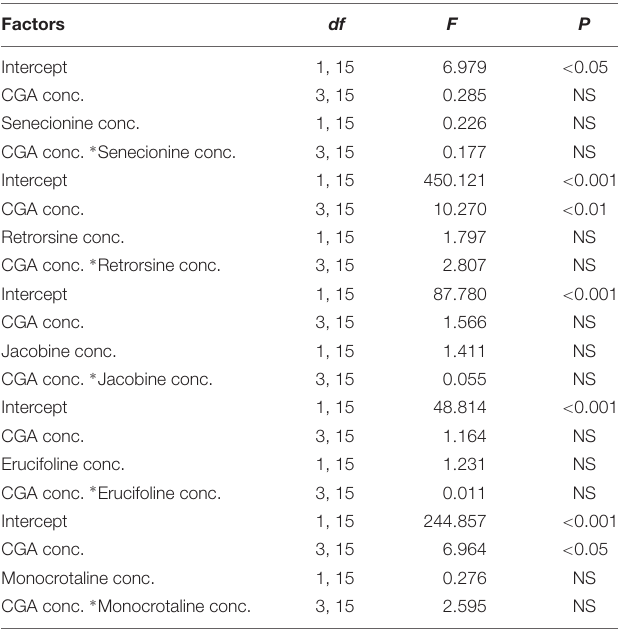
TABLE 1 | Two-way ANOVAs with PA free bases concentration and chlorogenic acid (CGA) concentration as fixed factors and the interaction effect minus one ( S X ∗ Y − 1 ) as the dependent